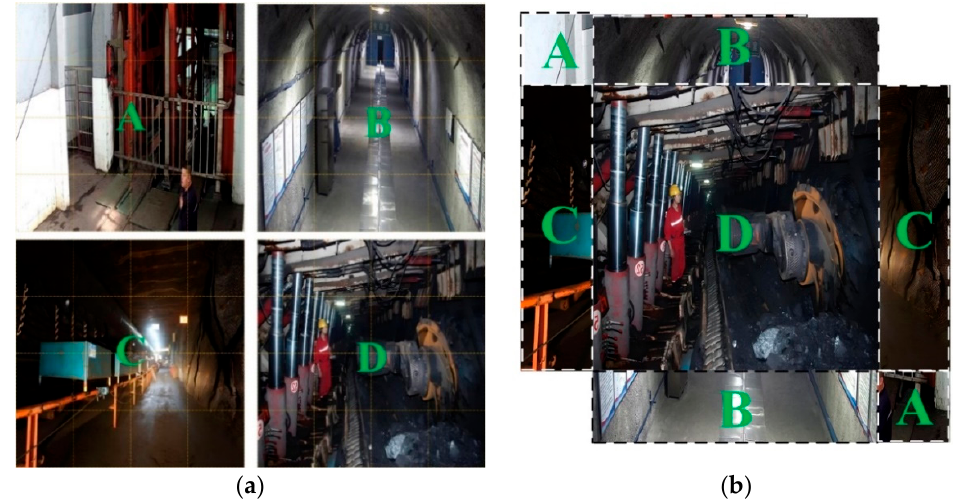
Figure 8. The division window effect. ( a ) W-MSA division window. ( b ) SW-MSA dividing win- dow.